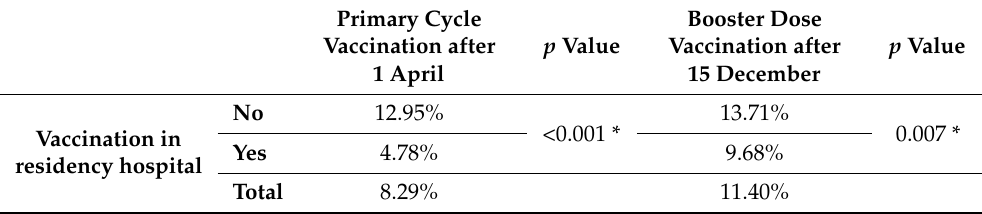
Table 3. Univariate analyses were performed using the Chi-Square test, with vaccination completed before compulsory policy (for primary cycle vaccination and booster dose), and vaccination in residency hospital as the covariate (* p < 0.05, statistically